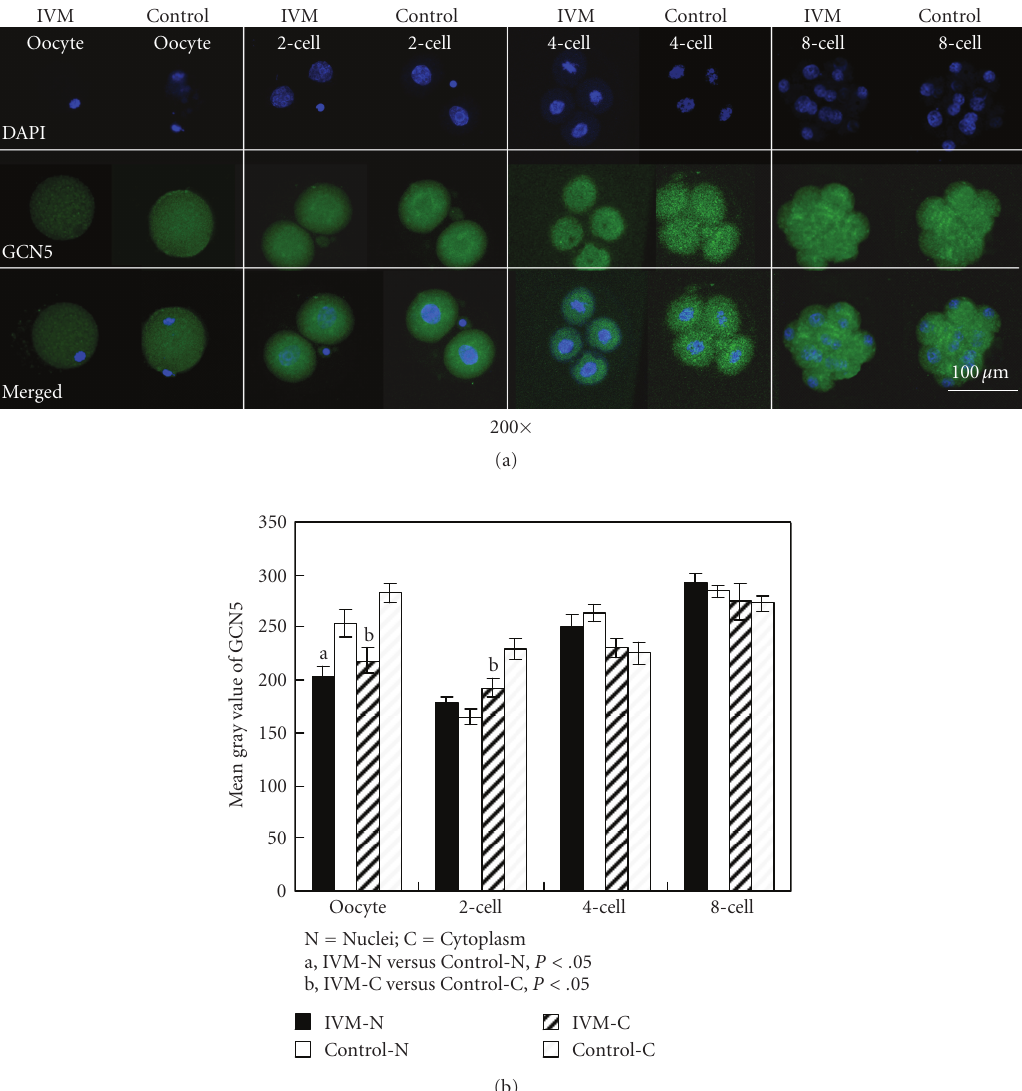
Figure 3: Fluorescence immunocytochemistry of GCN5 in oocytes and embryos. (a) Expressions of GCN5 in MII oocytes, 2-cell, 4-cell, and 8-cell embryos from IVM and control groups. Each sample was counterstained with DAPI (blue) to visualize the DNA. Specific goat polyclonal GCN5 was detected by fluorescein-conjugated antigoat secondary antibodies (green colour, FITC-labeled). Bar represents 100 μ m. (b) The gray value of GCN5 in oocytes and